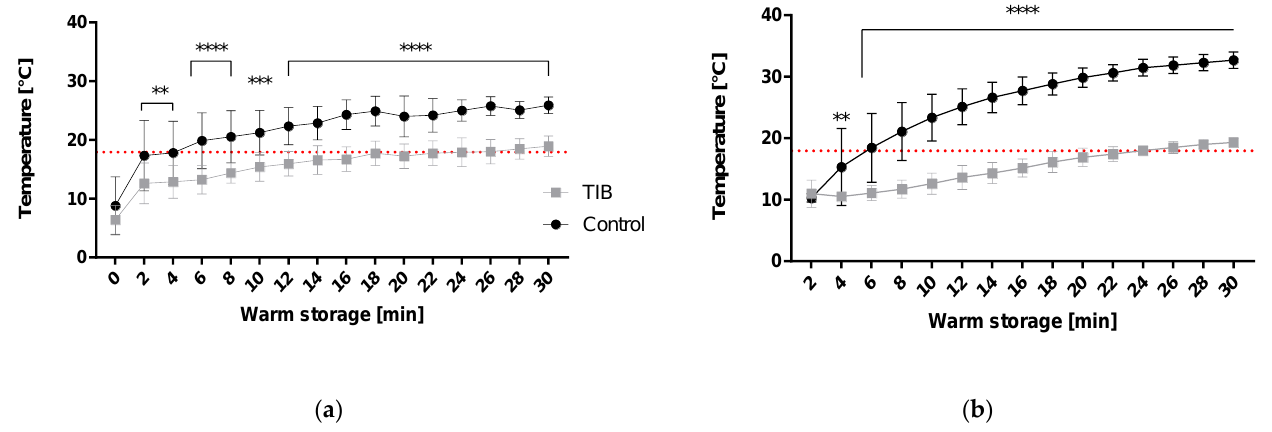
Figure 1. Temperature increase in a water bath at 38 ◦ C for 30 min. ( a ) Measurement of the superficial temperature (outside) ( b ) Measurement of the core temperature (inside). Red dashed line shows 18 ◦ C threshold for WI. ** p < 0.01, *** p < 0.001, **** p <